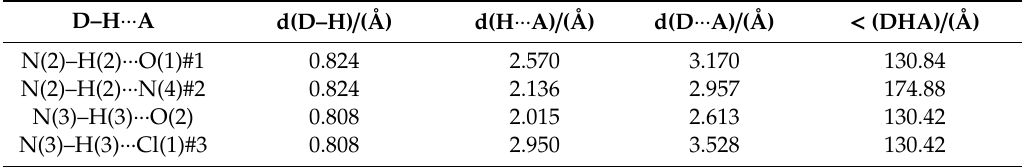
Table 3. Hydrogen bonding interactions of Compound 1